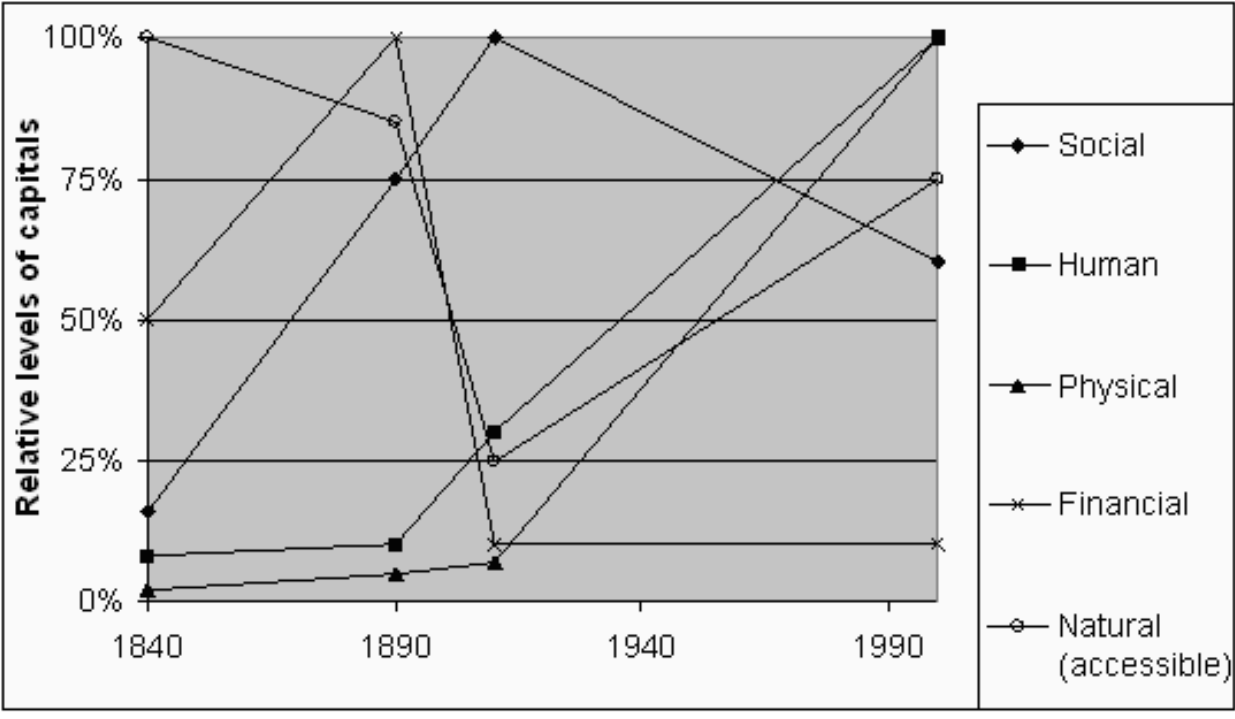
Fig. 6 . Postulated changes in levels of social, human, physical, financial, and natural capital during the history of the pastoral social-ecological system in New South Wales, Australia. The axes indicate selected years before and after the W and a stages. We believe that the